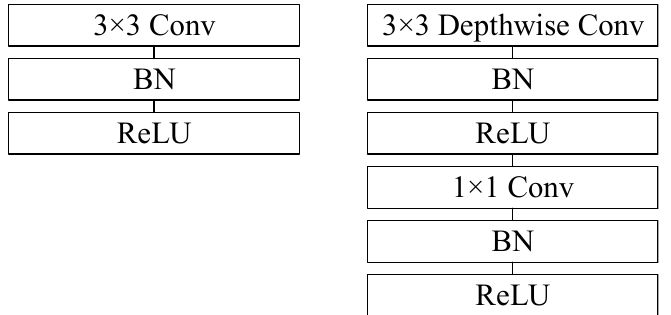
Figure 3. ( Left ) Standard convolution; ( right ) depth-wise separable convolution. MobileNetv2 adds linear bottleneck and inverted residual to MobileNetv1. Linear